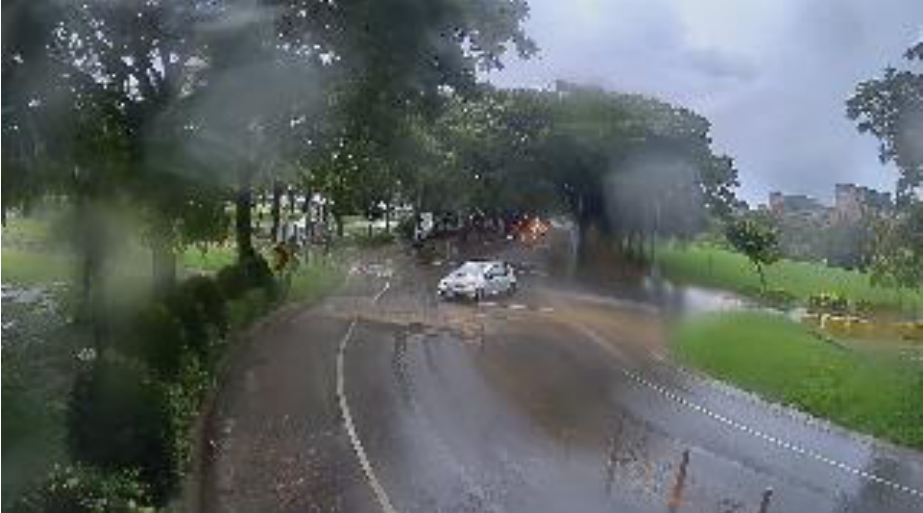
Figure 12. Sample image of a rainy day scene.